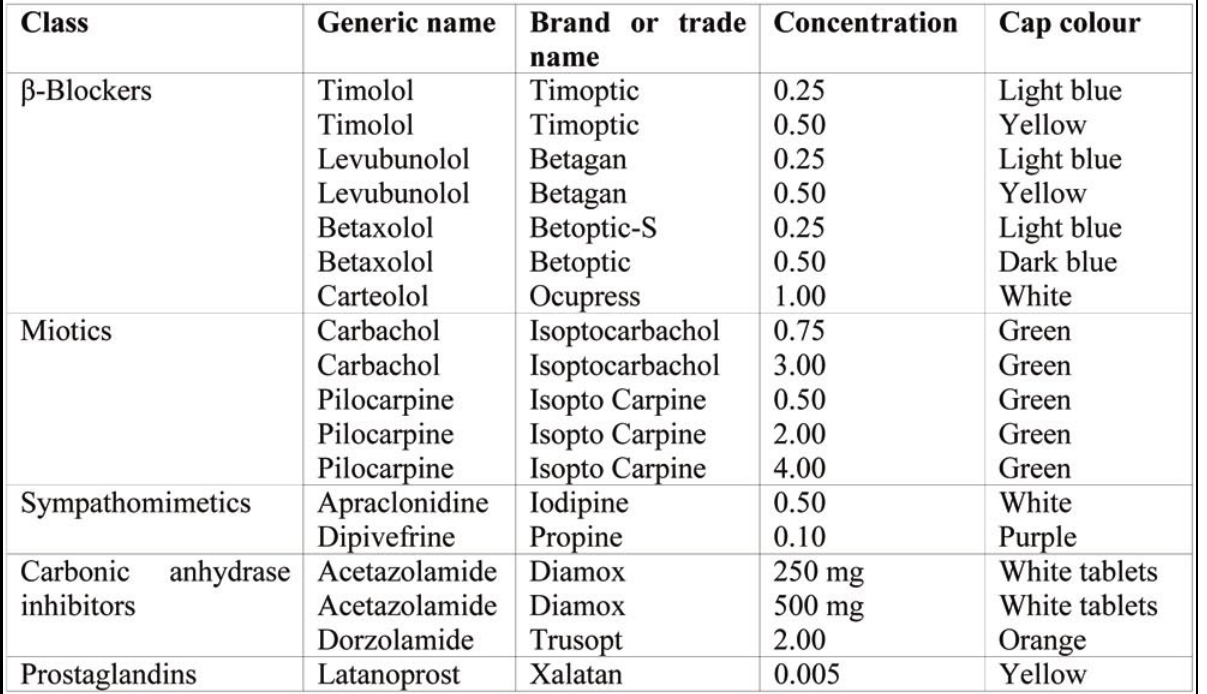
Table 2: Class, generic and brand names, concentration in percentage (%) and cap or tablet colour of commonly used antiglaucoma medications. The concentration for oral medications is in milligrams (mg